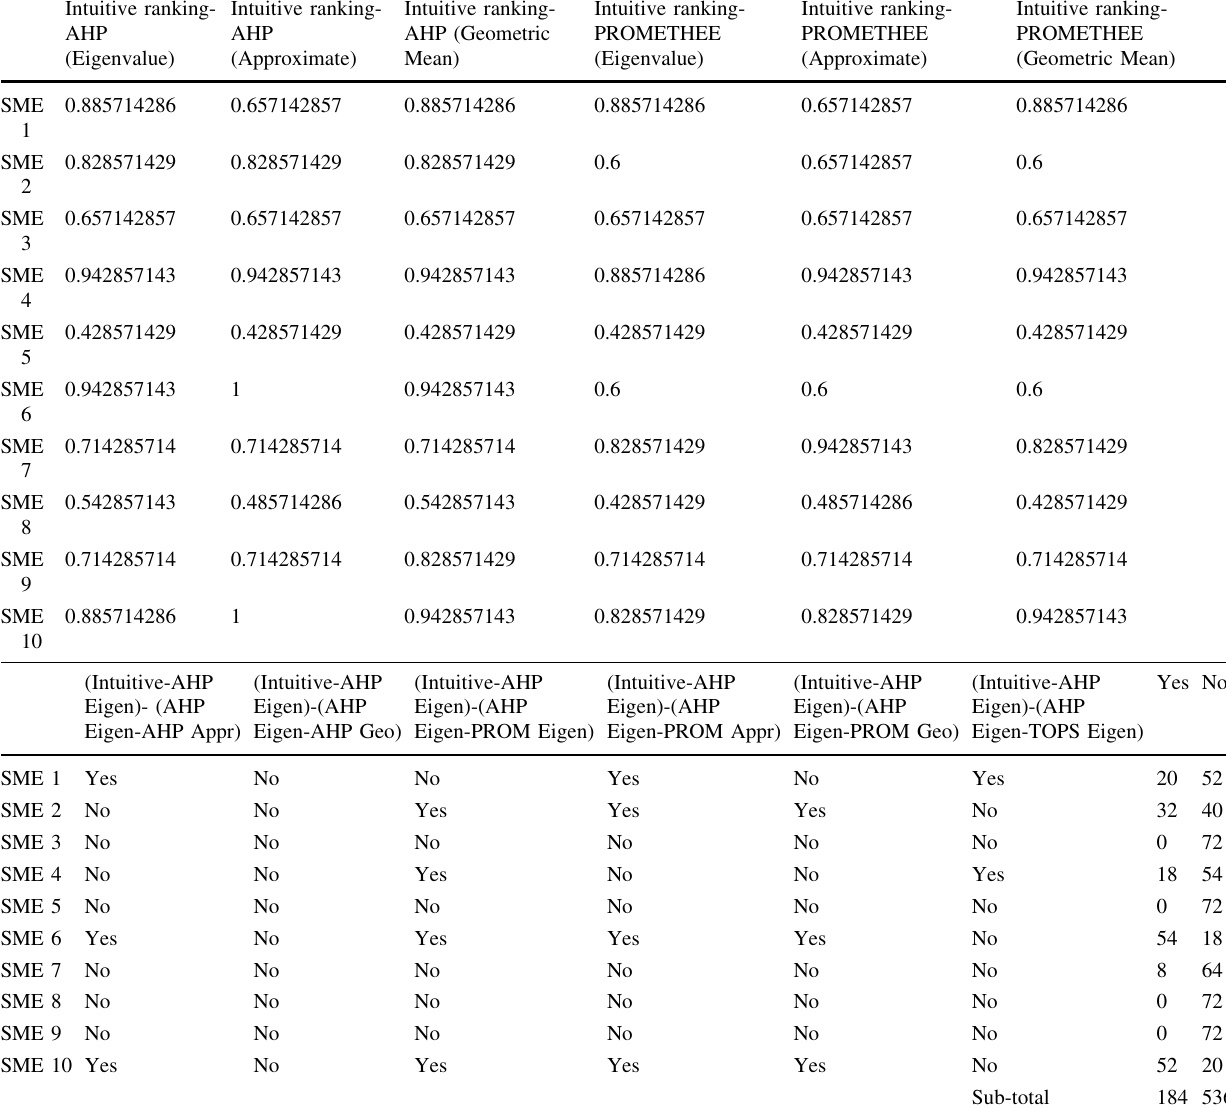
Table 21 Summary Spearman’s rank correlation